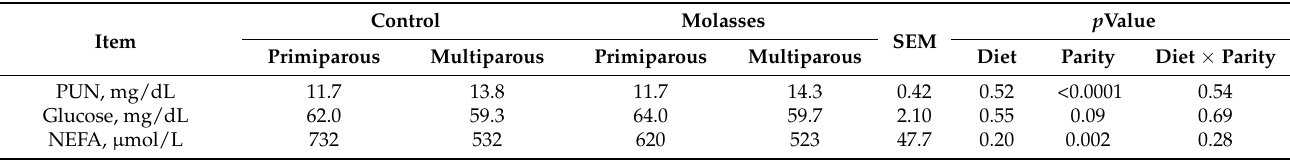
Table 6. Plasma urea nitrogen (PUN), glucose, and non-esterified fatty acids (NEFA) concentrations from blood collected on day 1, 3, 5, 7, and 15 of lactation for primiparous and multiparous cows fed control or molasses-containing diets during a 60 day dry period (Experiment